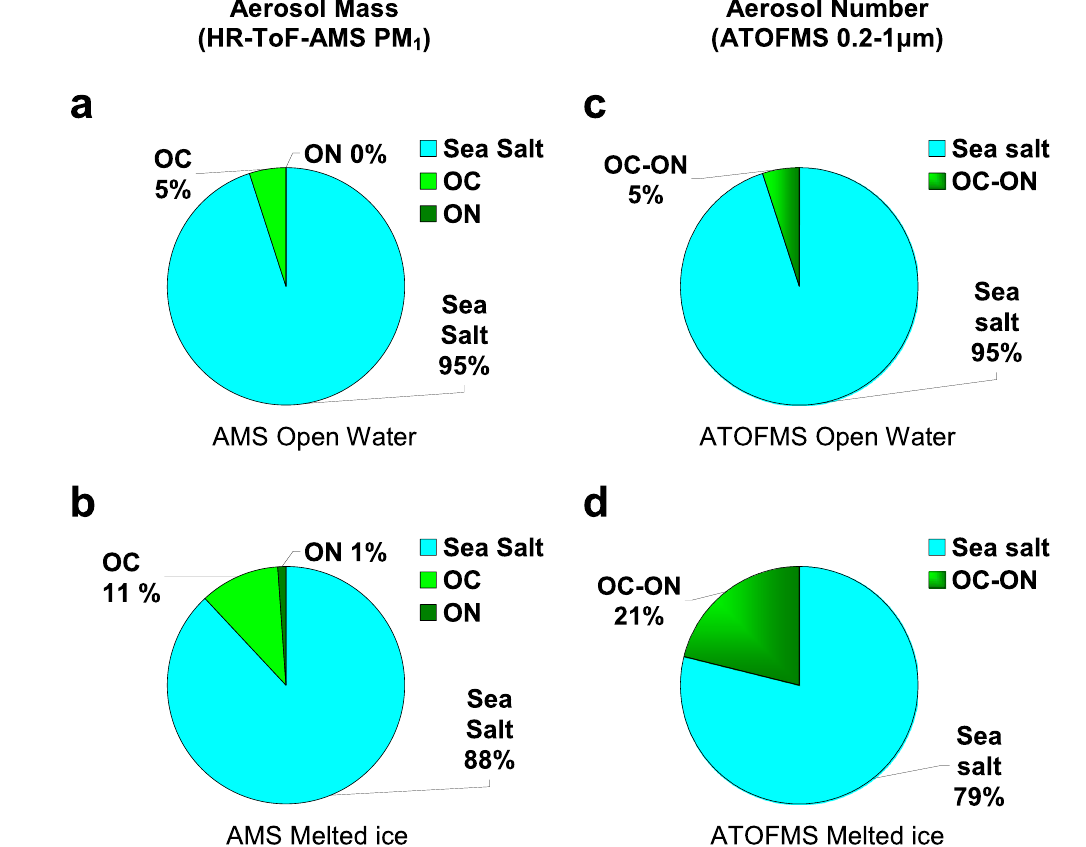
Figure 3. Single-particle composition of aerosols generated by a bubbling tank. ( a,c ) from bubbled open ocean water, and ( b,d ) from bubbled melted sea ice. ( a,b ) Contribution to the mass of aerosols < 1 µ m; ( c,d ) proportion of aerosol numbers contributed by internal mixtures. OC: organic carbon; ON: organic nitrogen. Note that in c and d , OC-ON refer to internal mixtures of organic carbon and nitrogen with sea salt.